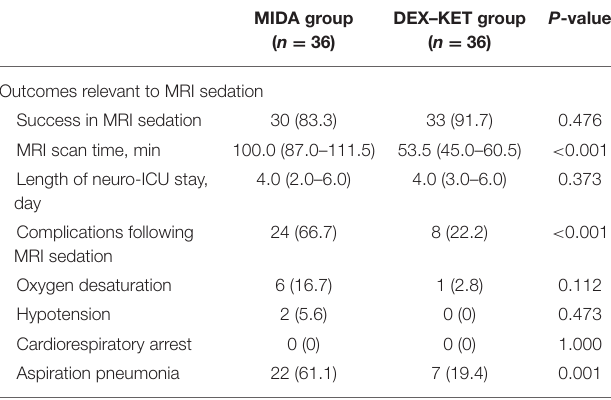
TABLE 3 | Outcomes and complications according to the MRI sedation